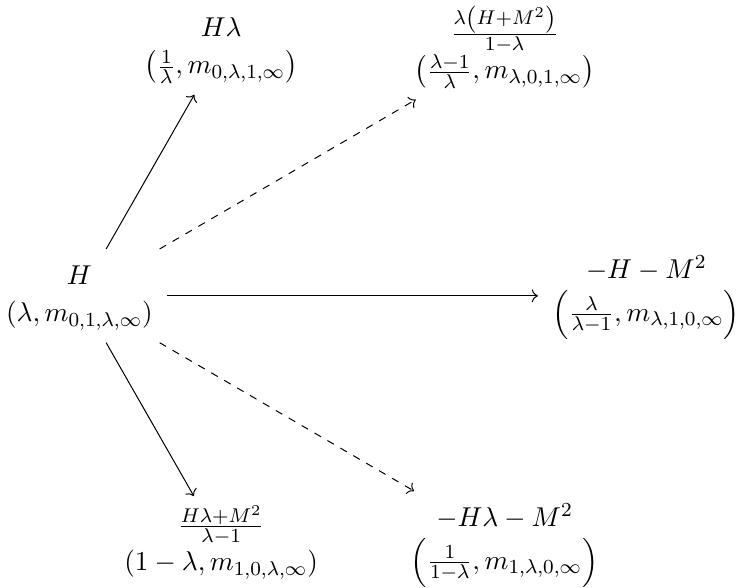
Figure 11 . Action of the orbifold group S 3 on the (cid:21) , the masses and the Hamiltonian H = H 2 ; 0 . The plain arrows correspond to the transpositions, also presented in table 2, while the dashed arrows represent the three-cycles. To each (cid:12)xed point of the S 3 action on the parameter space is associated a